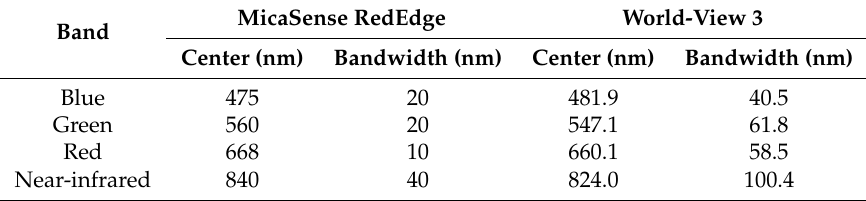
Table 1. Specifications of the utilised bands of the MicaSense RedEdge UAV-mounted camera, and the World-View 3 satellite